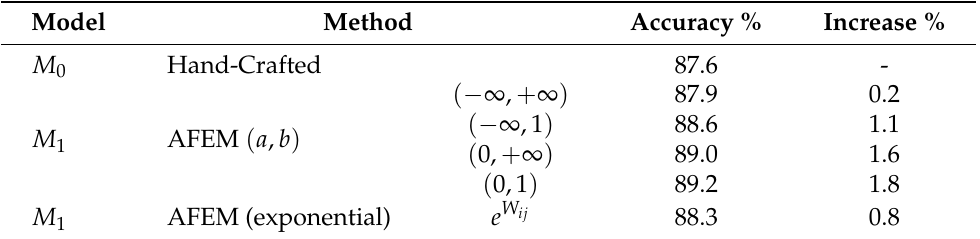
Table 4. Effect of different weight constraint settings on the performance of AFEM (validation